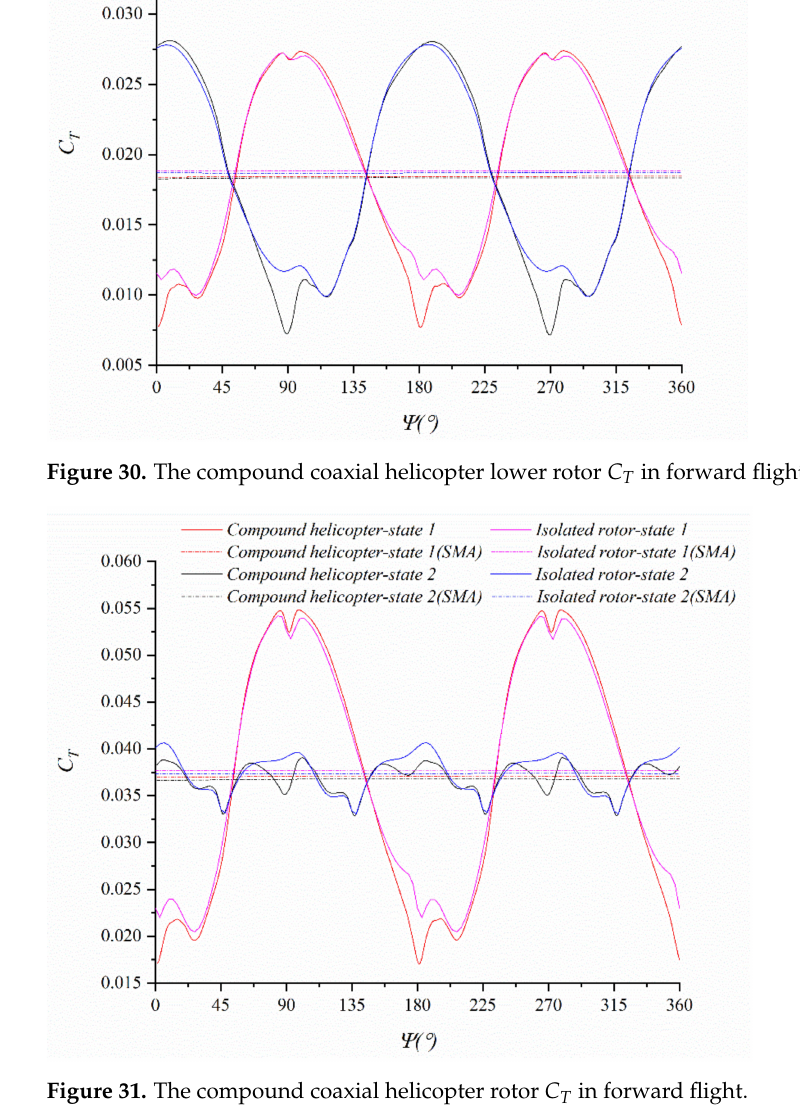
Figure 31. The compound coaxial helicopter rotor C T in forward